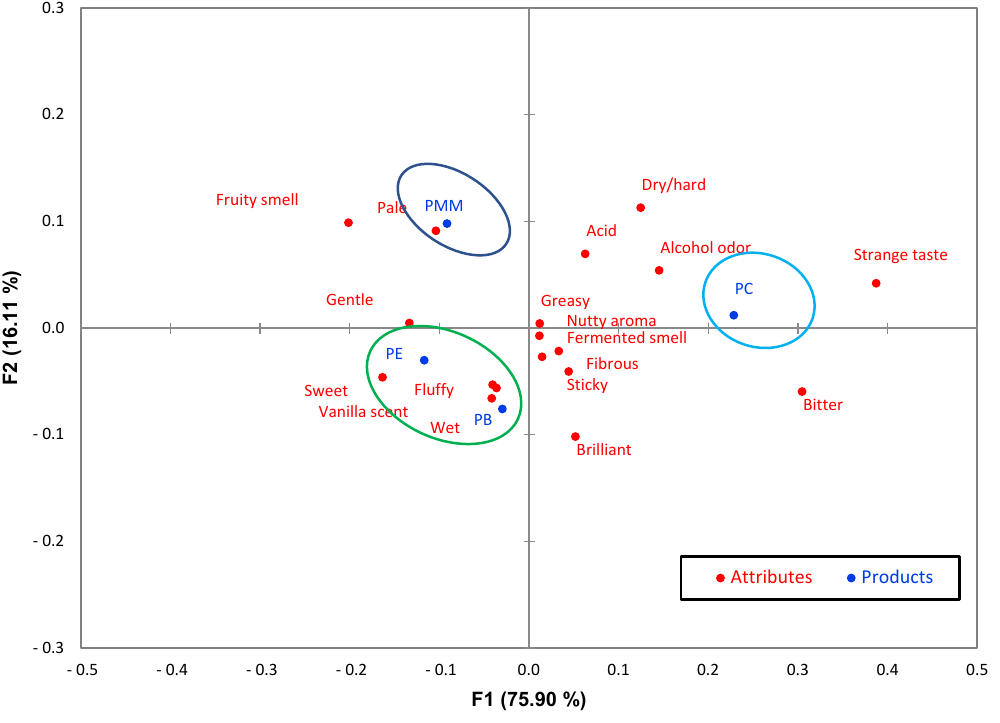
Figure 2. Correspondence analysis graph using the CATA method.